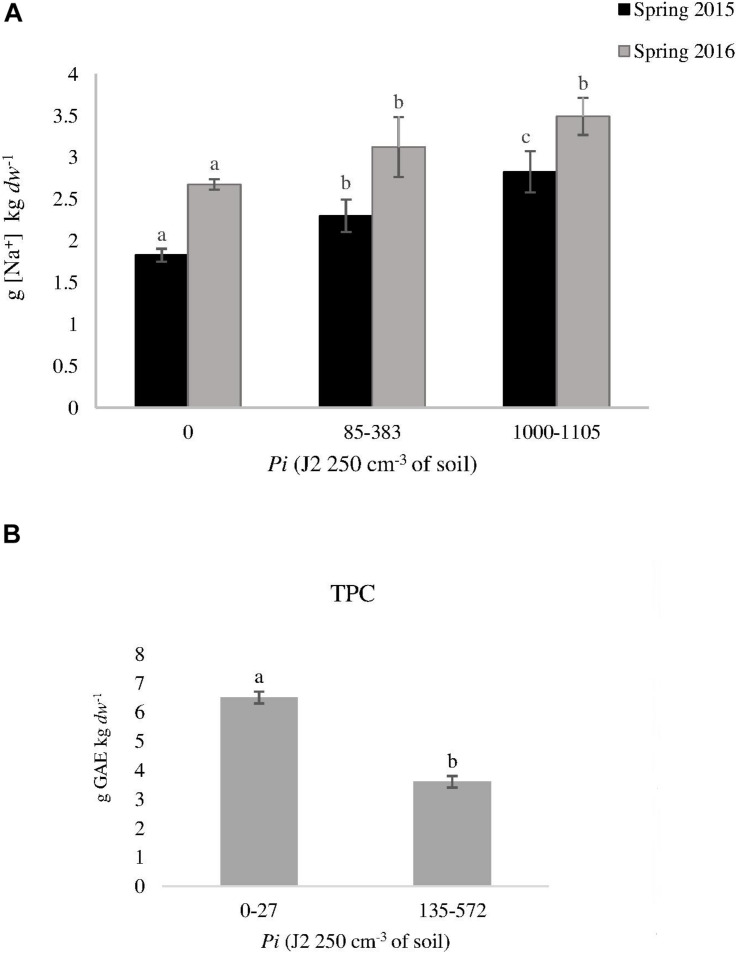
Effect of nematode density at transplanting (Pi) on (A) sodium concentration [Na+] in tomato fruits produced on ungrafted tomato cv. Durinta (T) cultivated in spring 2015 and 2016, and on (B) phenolic compounds in summer 2016. Data are mean ± standard error (n = 5). Column of the same year with the same letter did not differ (P < 0.05) according to the non-parametric Kruskal–Wallis test (A) or to the non-parametric Wilcoxon test (B).